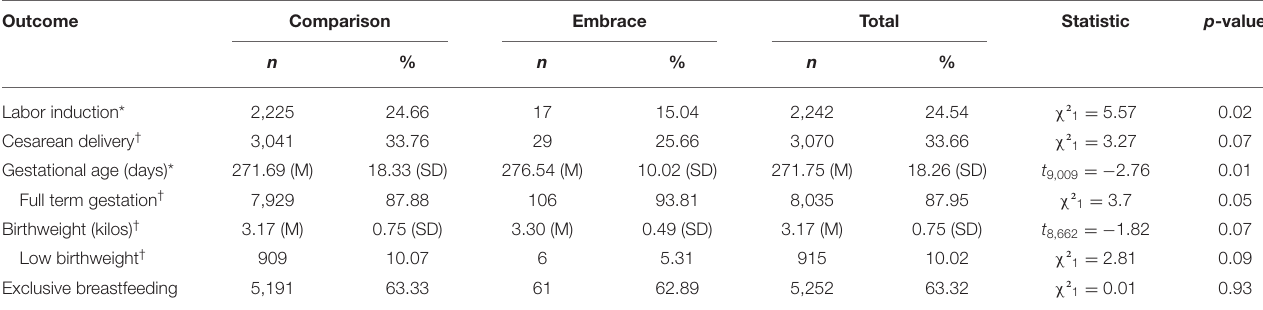
TABLE 2 | Bivariate statistics by Embrace participation/comparison group at Emory Decatur Hospital from 2016 to 2018. Outcome Comparison Embrace Total Statistic p -value n